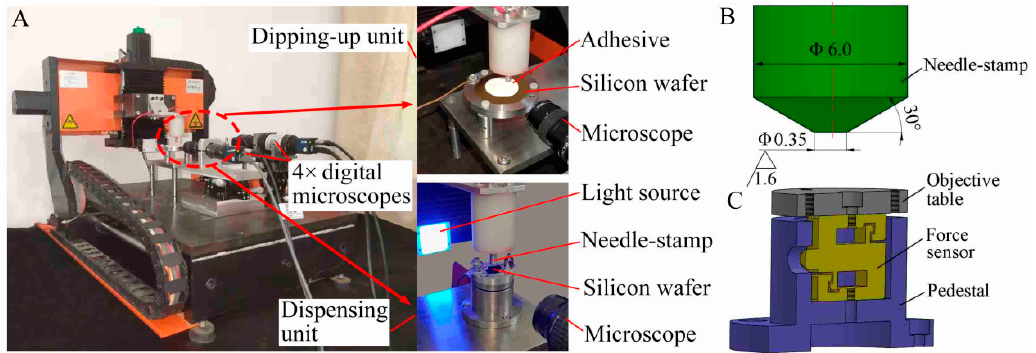
Figure 3. ( A ) Home-made experimental dispensing device with force-feedback, ( B ) needle-stamp, and ( C ) force sensor.